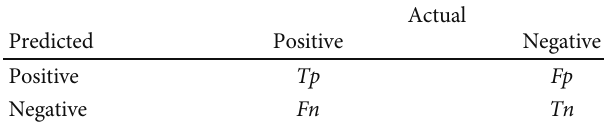
Figure 4: Model training curves. Table 1: Confusion